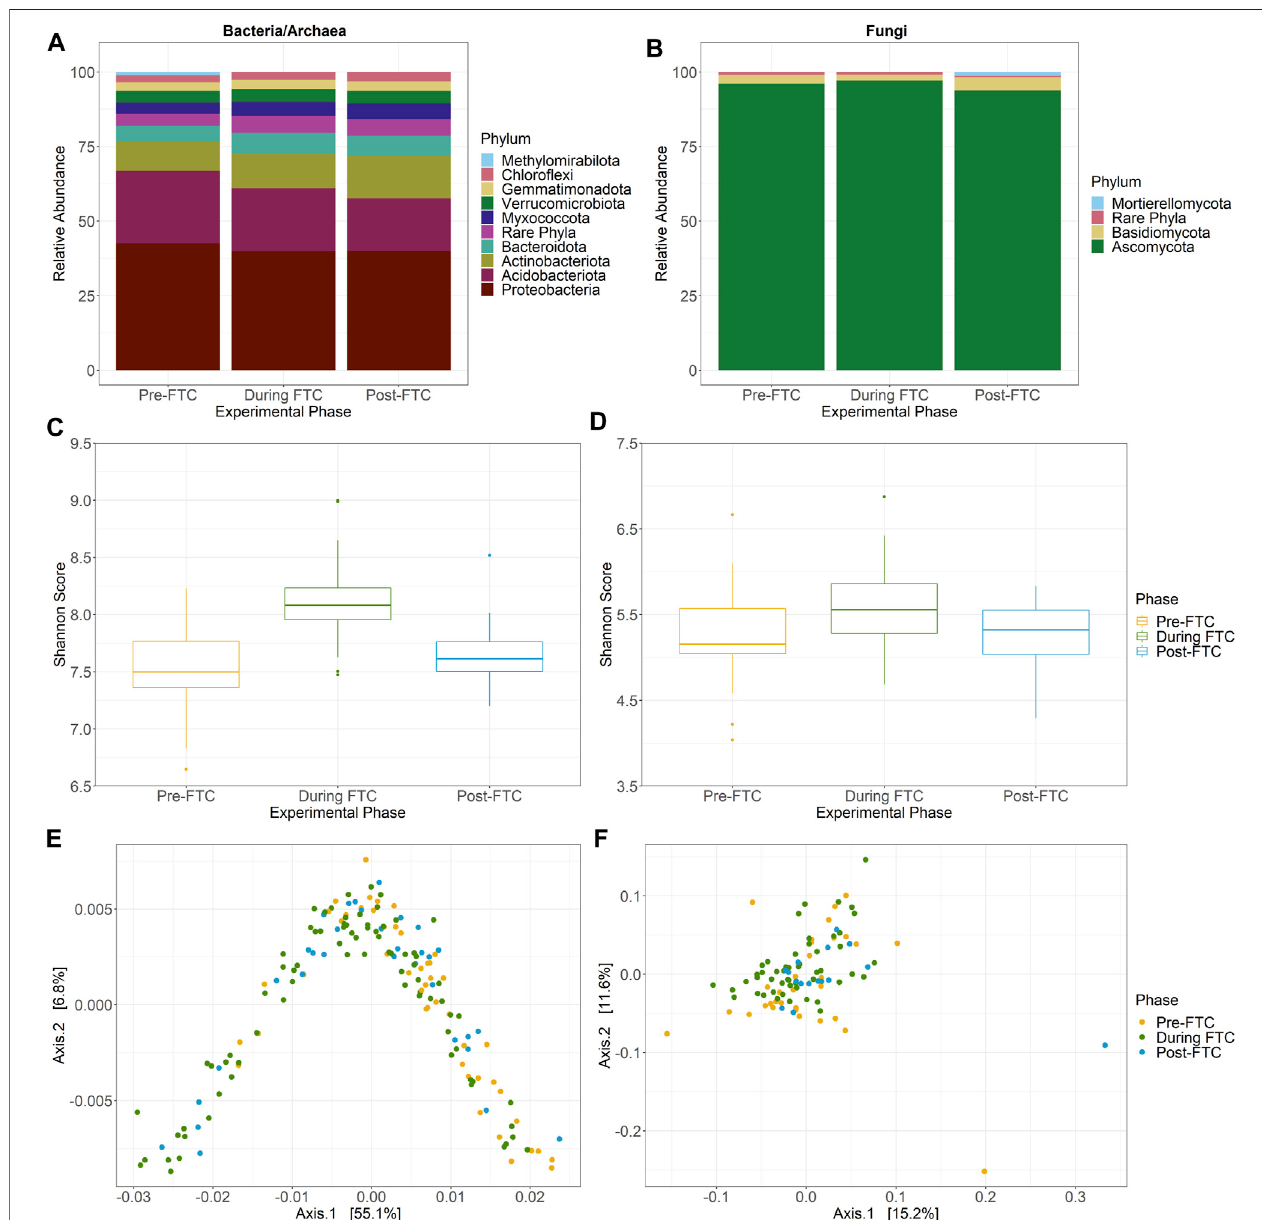
FIGURE3| Communitycompositionanddiversityacrossphase.Bacterialandarchaeal (A) ,andfungal (B) communitycompositionatthephylumlevelacrossFTC phases. ASVs identi fi ed from QIIME2 were then classi fi ed using the Silva 138 99% OTUs (A) or UNITE 8.2 99% dynamic OTUs (B) reference sequences. “ Rare phyla ” encompass all phyla below 1% relative abundance. The bacterial/archaeal community are dominated by Proteobacteria and Acidobacteria with diminishing abundance of the Acidobacteria and increasing abundance of Actinobacteria over time. The fungal community is predominately Ascomycota with little observed variation over time. (C,D) Bacterial and archaeal (C) , and fungal (D) alpha diversity Shannon score across FTC phases in boxplot distributions collapsing column, depth, and time into phases. Signi fi cant differences, detected by the Tukey HSD test, distinguish the During FTC phase from the others among the bacterial and archaeal community but no such difference exist for the fungal community. Bacterial and archaeal (E) , and fungal (F) beta diversity by PCoA generated with weighted Unifrac distances across FTC phases. Principal axis for the bacterial/archaeal community account for a high degree of variation and possess a distinct horseshoe shape with slight separation by phase. Little variation is explained for any principal axis in the fungal community and sites do not appear to cluster by phase.